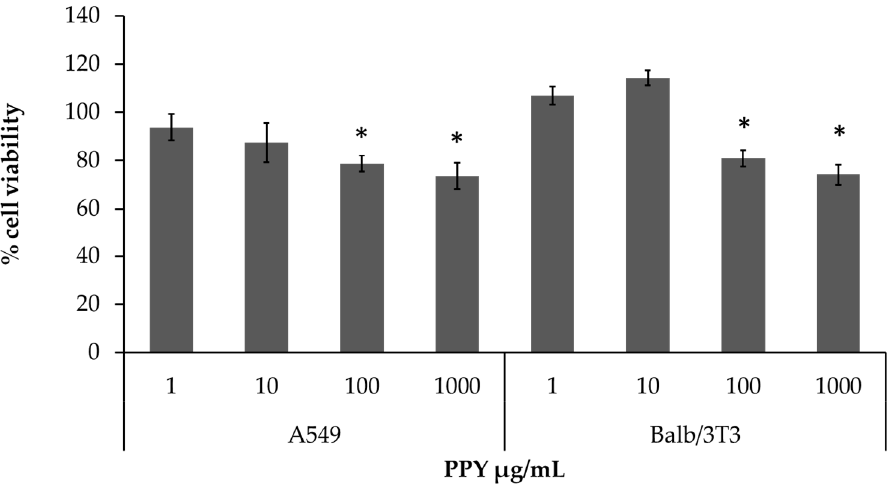
Figure 4. Cell viability. The MTT test was performed on A549 and Balb/3T3 cells after exposure for 24 h to increasing concentrations (1, 10, 100, and 1000 µg/mL) of PPy NPs. Data represent the mean ± SE of at least three independent experiments. * Statistically different compared to control samples. p < 0.05. One-way ANOVA +